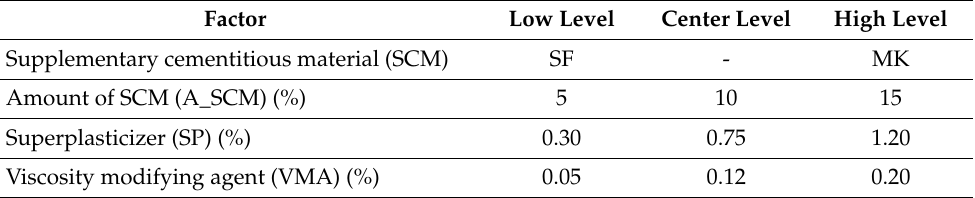
Table 3. Factors and levels used in the screening design. Factor Low Level Center Level High